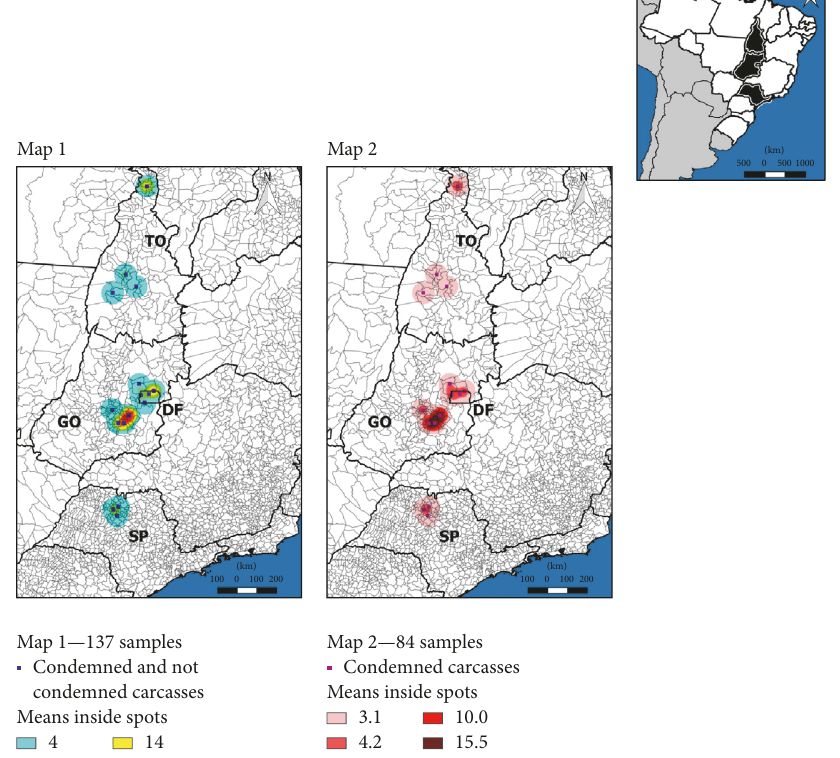
Figure 1: Spatial kernel density estimator of the total E. coli strains isolated in the respiratory tract, liver, and heart of broilers at a slaughterhouse according to the city of origin of the batch of broilers (Map 1) and the kernel density estimator of the E. coli strains isolated from the respiratory tract, liver, and heart of broilers condemned suspect of colibacillosis according to the origin of the batch of broilers (Map